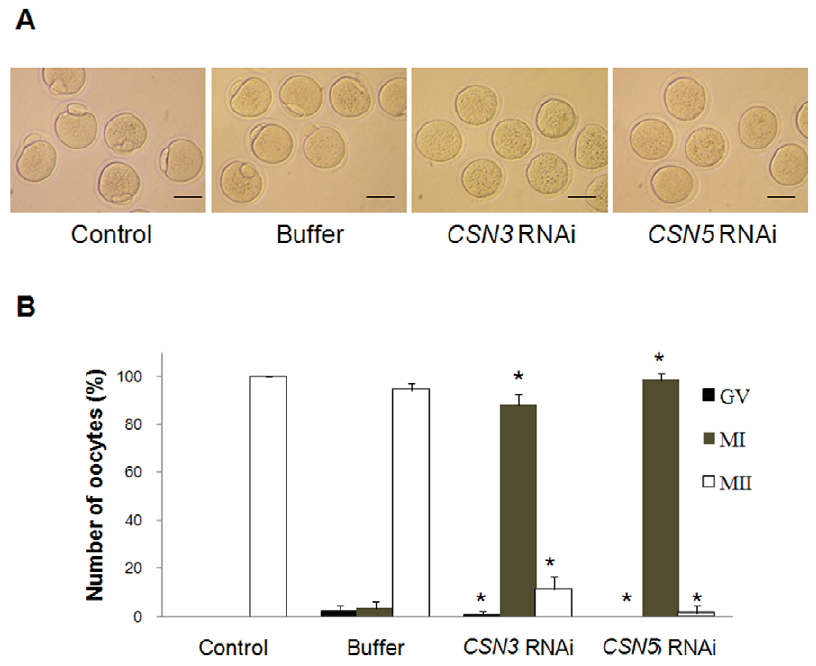
Figure 3. Microinjection of CSN3 or CSN5 dsRNA into GV oocytes resulted in MI arrest. Microphotographs of oocytes (A) and maturation rates (B) after in vitro culture for 16 h. Control and buffer-injected groups were MII after 16 h in culture, but injected oocytes were arrested at the MI stage. Bars=50 m m. Asterisks indicate statistically significant differences compared to that of control or buffer group (p , 0.05).